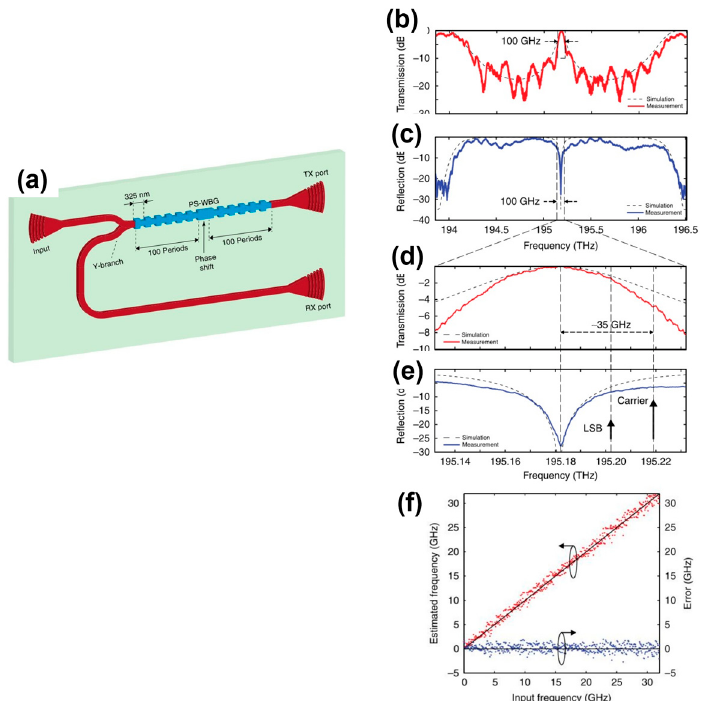
Figure 13. ( a ) Schematic of the silicon phase shifted WBG (PS-WBG) employed as a linear-optics frequency discriminator reported in [103]. TX port, transmission port; RX port, reflection port. Simulated (dashed line) and measured (solid line); ( b ) linear optical transmission and ( c ) reflection spectral responses of the PS-WBG; ( d , e ) zoom with overlapped OSSB+C spectrum. ( f ) Estimated frequency (red dots) and corresponding error (blue